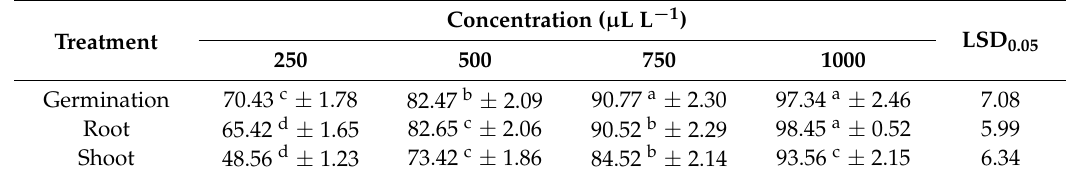
Different letters within each row indicate values significant variation p ≤